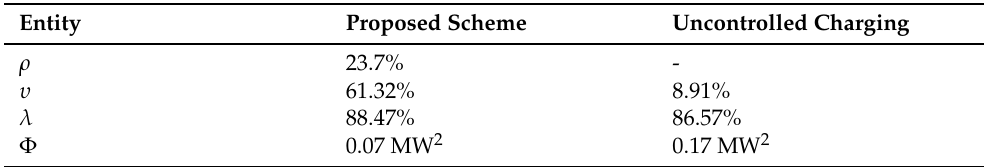
Table 3. Comparison of proposed scheme and uncontrolled charging on IEEE 13-node distribu- tion feeder.